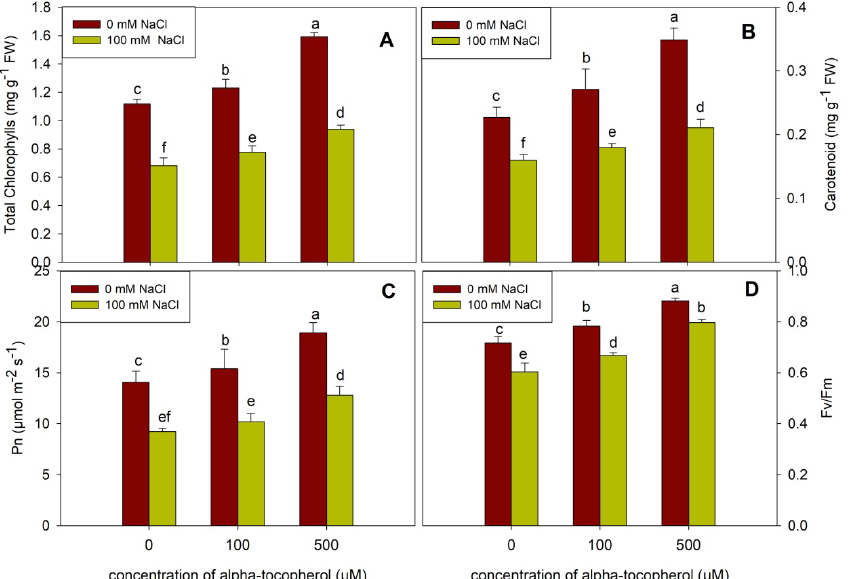
Fig. 2: Effect of increased salinity (100 mM NaCl) stress with and without exogenous application of α - tocopherol (100 and 500 μM) on (A) total chlorophylls, (B) carotenoids, (C) photosynthesis (Pn) and (D) PSII activity in soybean ( Glycine max ). Values are mean (±SE) of five replicates and different letters represent significant difference at P<0.05.